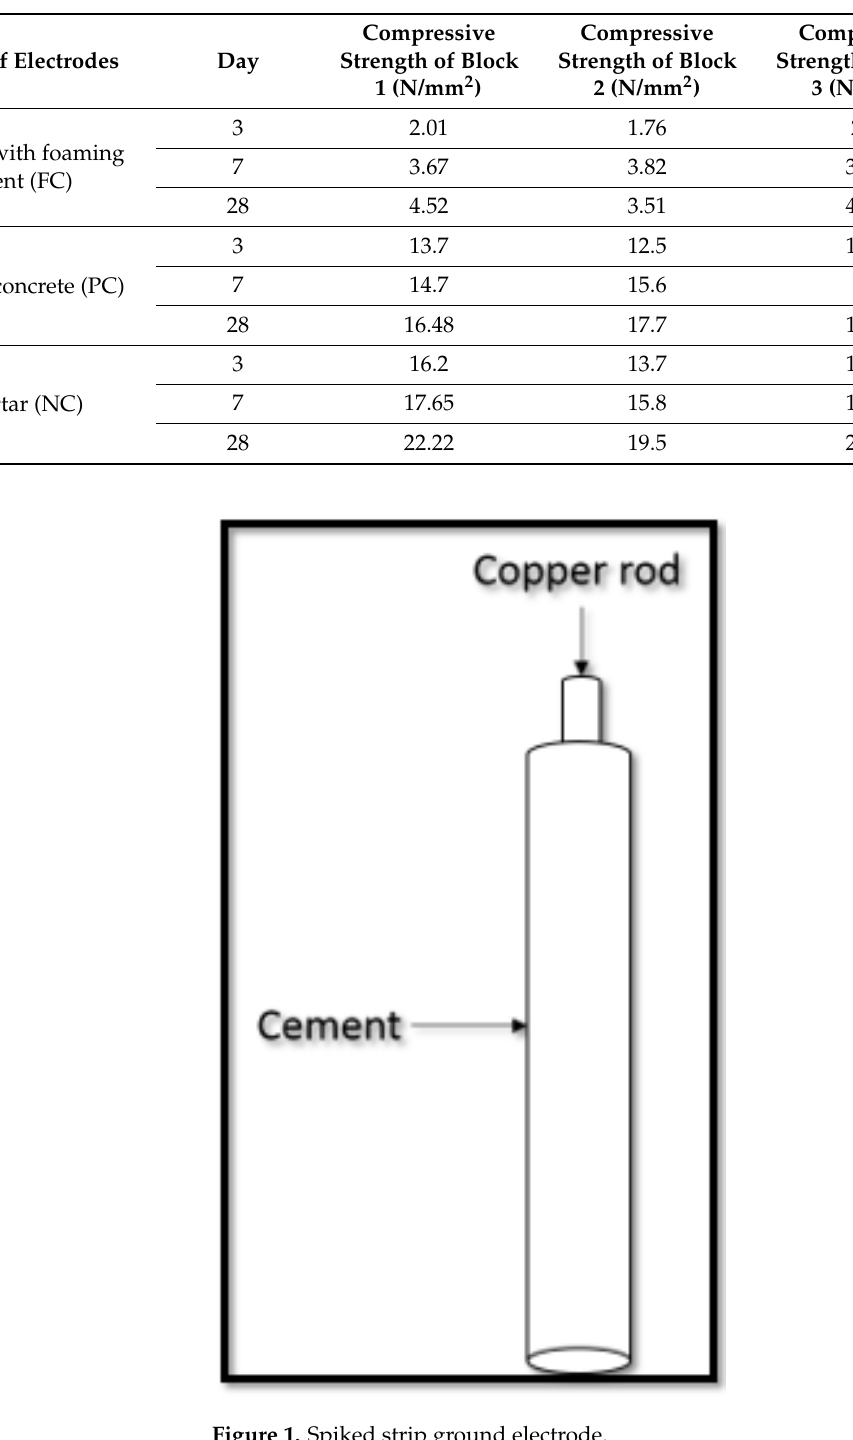
Table 3. Compressive strengths of the blocks.